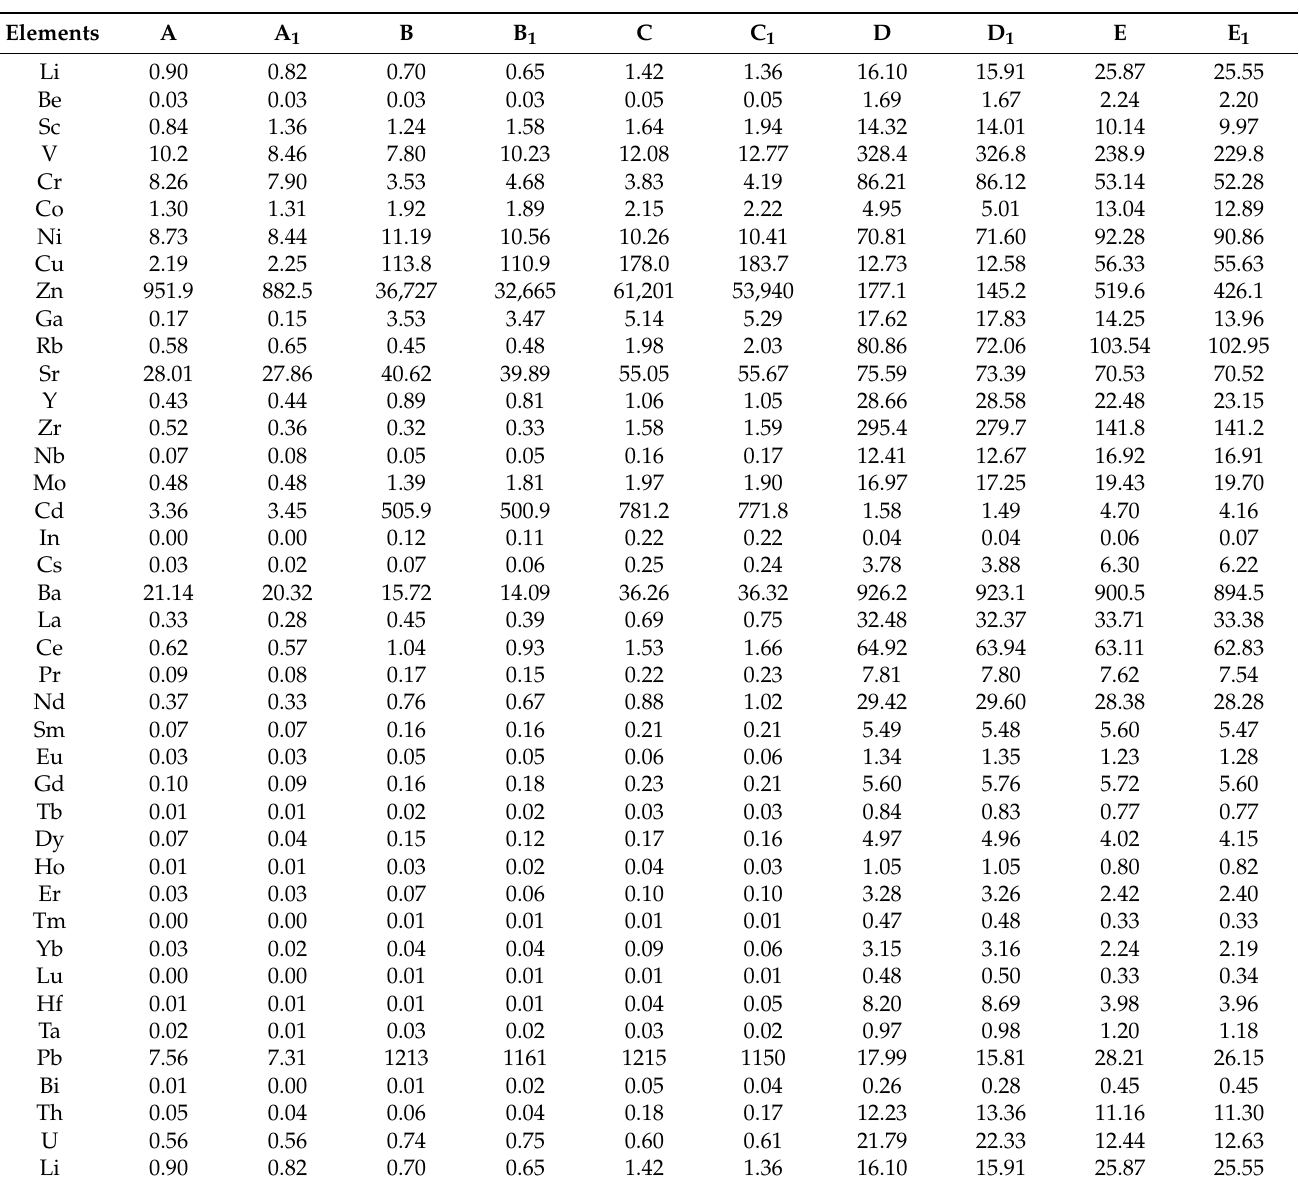
Table 2. The content of trace elements in the Mayuan Zn-Pb deposit